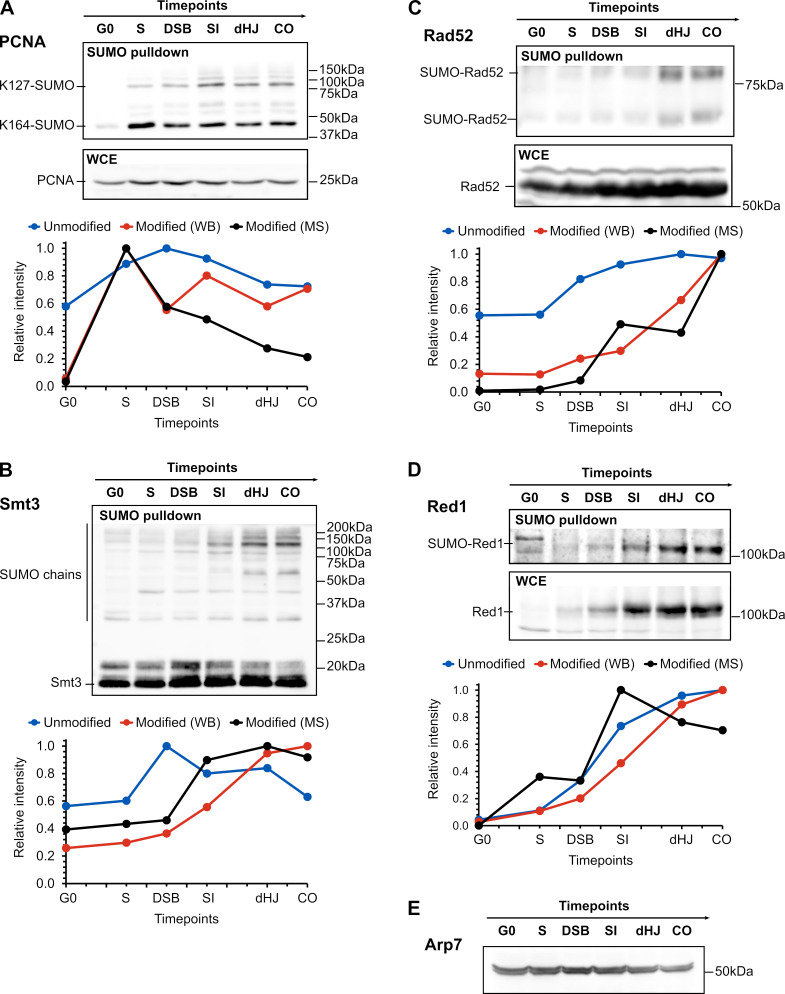
Western blot validation of SUMO targets.Western blot analysis of SUMO-modified and unmodified forms of: (A) PCNA, (B) Smt3, (C) Rad52, and (D) Red1 in SUMO enriched (6His-Smt3 Ni-NTA purified ‘SUMO pulldown’) and whole-cell extract (‘WCE’) samples, respectively. Timepoints correspond to those used for proteomics analysis. Graphs compare the relative intensity profiles of unmodified and SUMO-modified forms, estimated from quantifying western blots (WB), with the averaged relative LFQ intensity profiles for the SUMOylated protein (Modified [MS]). For quantification of western blots, intensities were adjusted to the loading control (Arp7) shown in panel E.